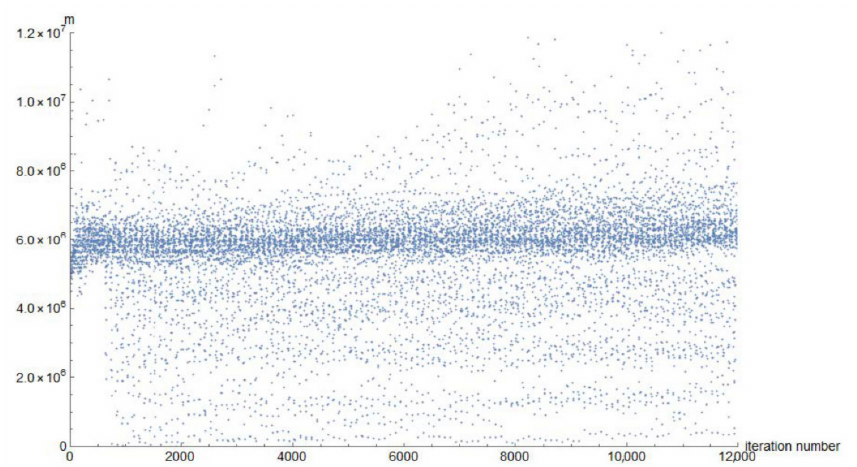
Figure 9. The results of the estimation of the EV market size (m) for Austria in successive iterations of the nonlinear least squares method [own